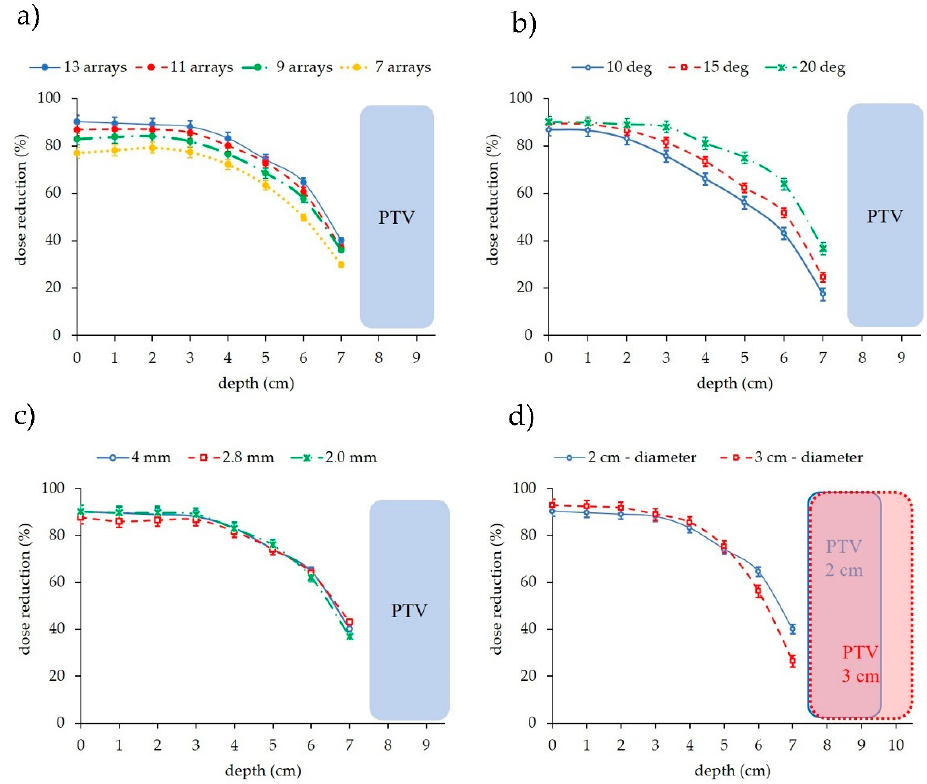
Figure 8. Dose reduction to normal tissues of pMBAT with respect to one-array pMBRT as a function of depth and ( a ) number of arrays forming the arc, ( b ) separation between arrays, ( c ) c-t-c distance, and ( d ) PTV diameter in pMBAT.